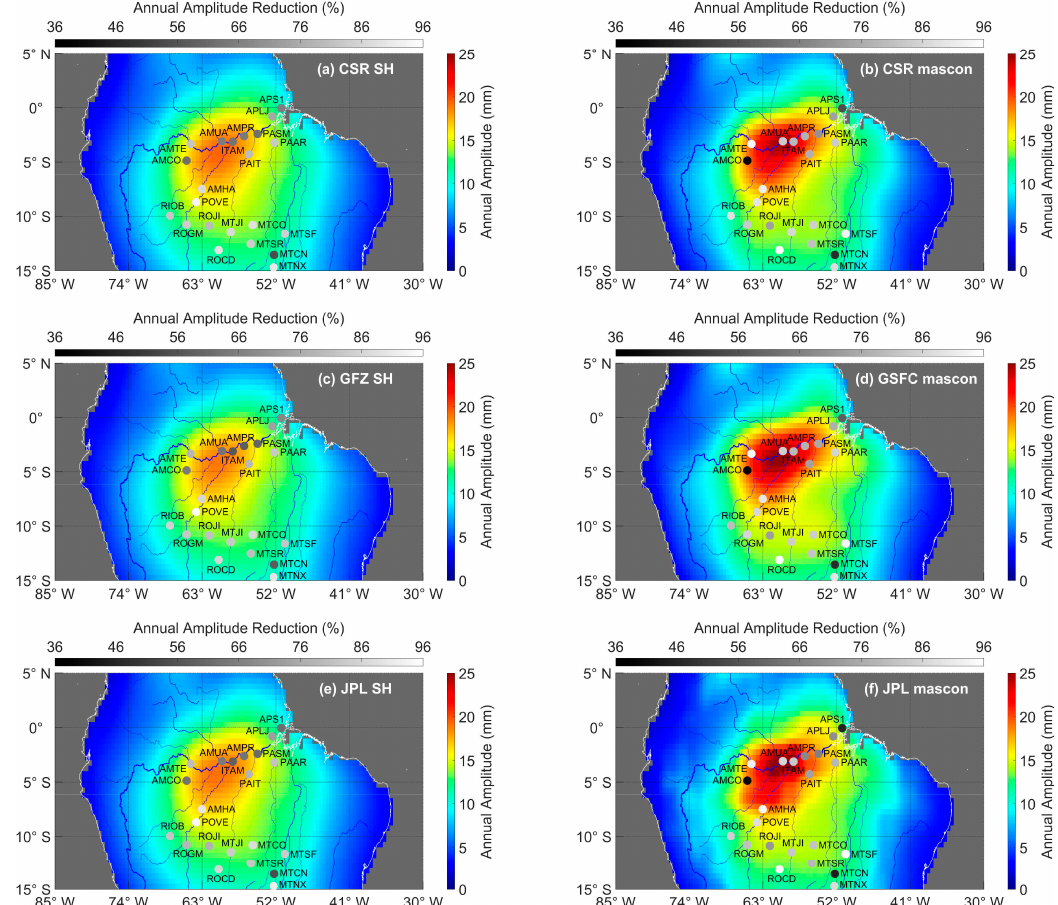
Figure 3. The annual amplitude reductions after removing GRACE/GRACE-FO derived displace- ments from the GNSS heights at the 22 selected stations, using different products: ( a ) CSR SH, ( b ) GFZ SH, ( c ) JPL SH, ( d ) CSR mascon, ( e ) GSFC mascon, and ( f ) JPL mascon. The gray scales of the round dots represent the values of annual amplitude reductions. The background colors represent the annual amplitudes of vertical loading deformation derived from GRACE/GRACE-FO.